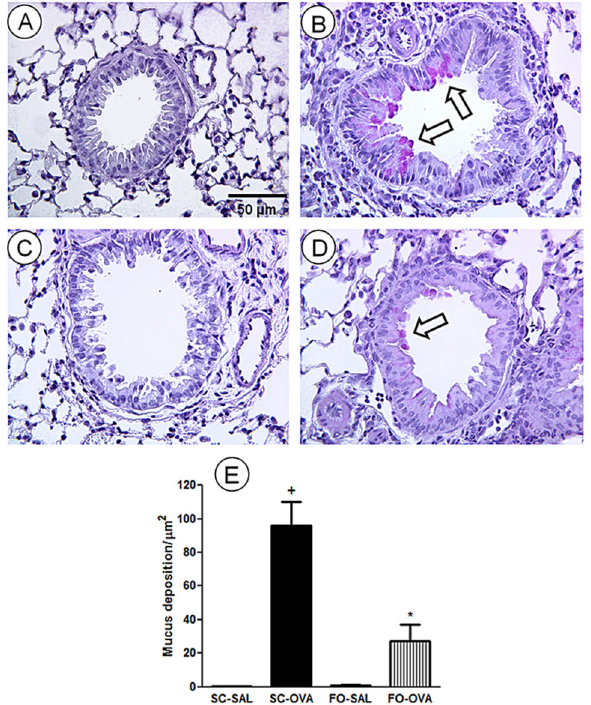
Figure 4. Effect of FO intake on allergen-evoked mucus production in A/J mouse lungs. Photomicrographs were taken of representative airways from (A) sensitized, saline- challenged (SC-SAL); (B) sensitized, ovalbumin-challenged (SC-OVA); (C) sensitized, saline-challenged with fish oil (FO- SAL) and (D) sensitized, ovalbumin-challenged with fish oil (FO-OVA). (E) Quantitative assessment of mucus production was performed by morphometric analyses. The analyses were performed 24 hours after the last challenge. Slides were stained with periodic acid-Schiff. Arrows indicate representative mucus deposition. In the signaled cases, P <0.05 compared with the SC-SAL group (+) and the SC-OVA group (*) (one-way ANOVA and post-hoc Holm-Sidak test). Values are the means ± S.E.M and are representative of 1 experiment (n=5 per